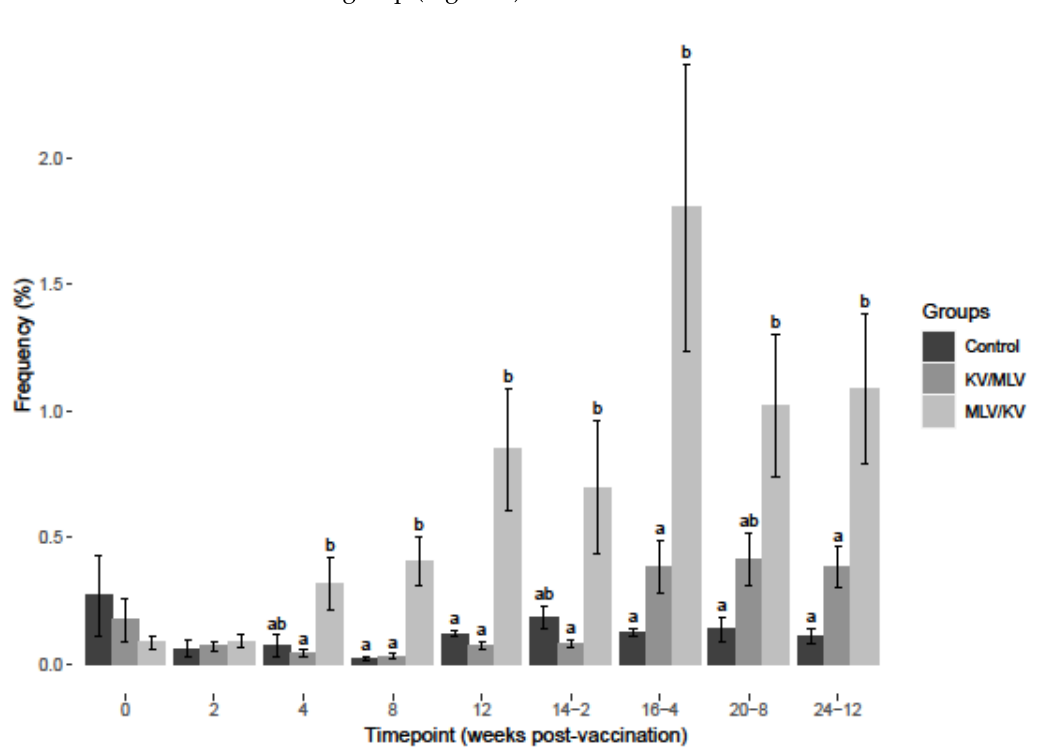
Figure 3. Frequency of IFN- γ mRNA-positive CD4 + cells after 24-h stimulation at each respective timepoint over the course of the study with BVDV-2a (PI-28). Values at each timepoint, not connected by the same letter are significantly different ( p < 0.05).